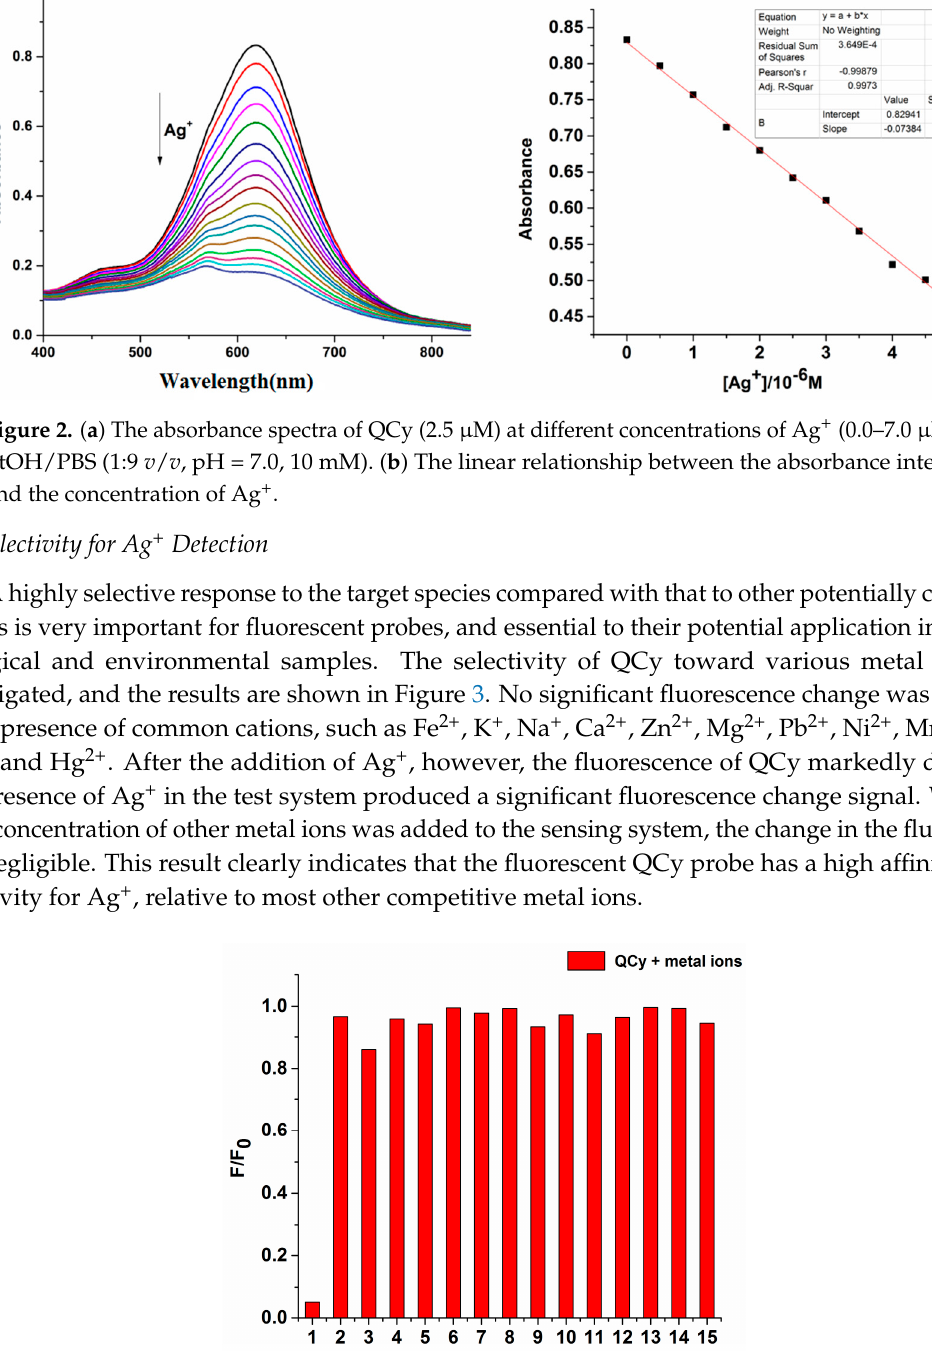
Figure 1. Fluorescence titration studies of QCy. ( a ) Fluorescence spectra of QCy (2.5 μ M) upon addition of Ag + (0.0 – 7.0 μ M) in ethanol/phosphate ‐ buffered saline (EtOH/PBS) (1:9 v/v, pH = 7.0, 10 mM); ( b ) The linear relationship between the fluorescence intensity and the concentration of Ag + . The excitation wavelength was 619 nm, and the emission wavelength was 760 nm.